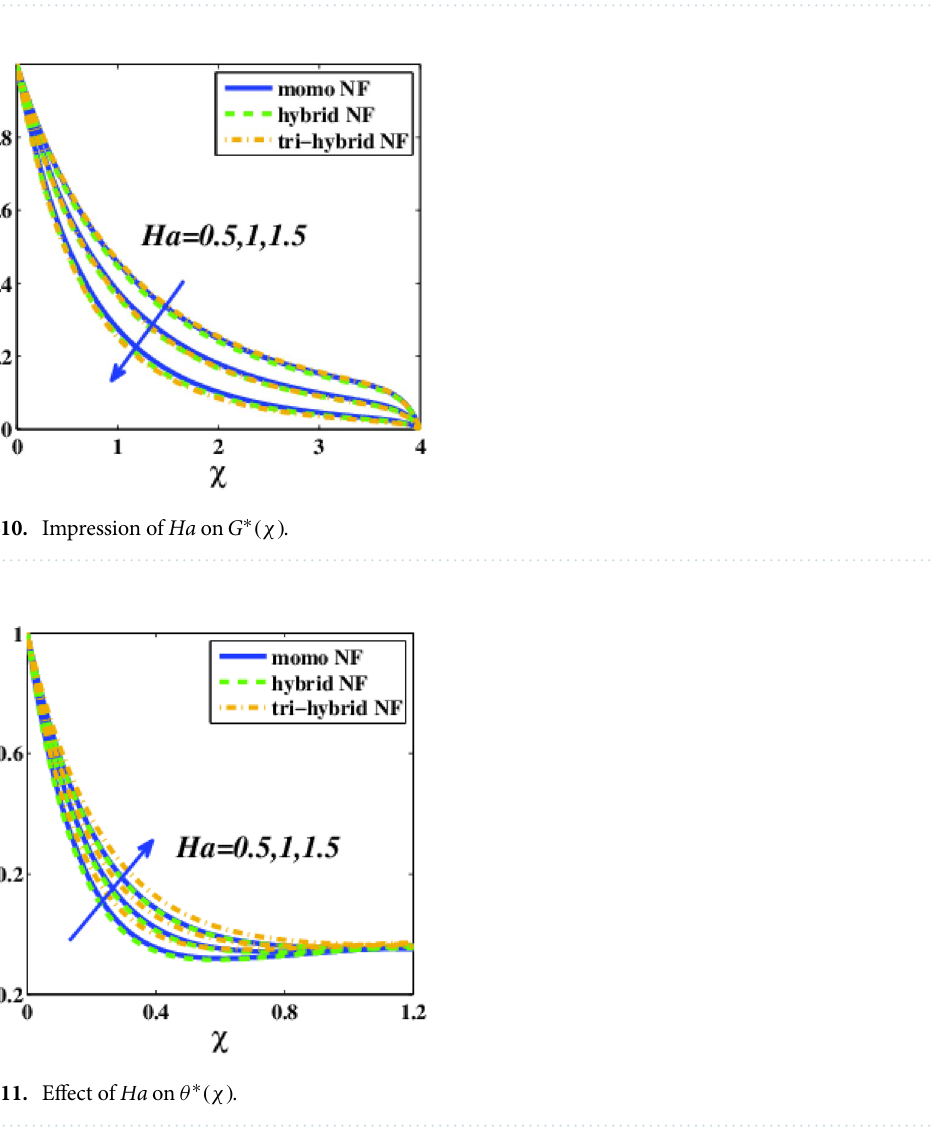
Figure 9. Inspiration of Ha on F ∗ ′ (χ) .